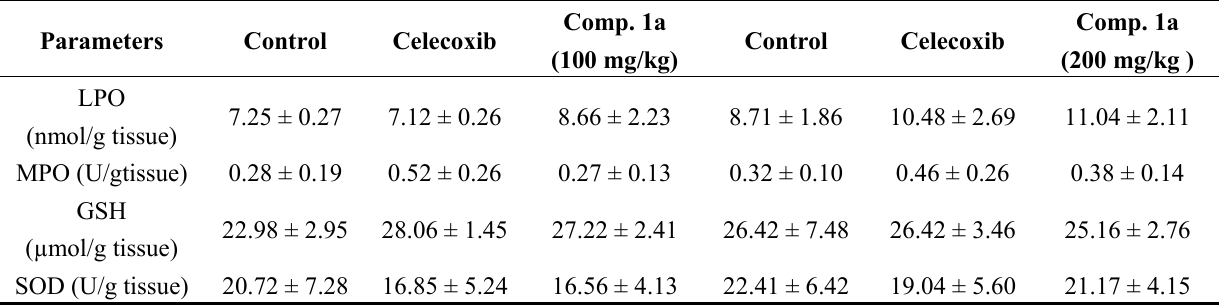
Table 5. Oxidative stress parameters in colon.